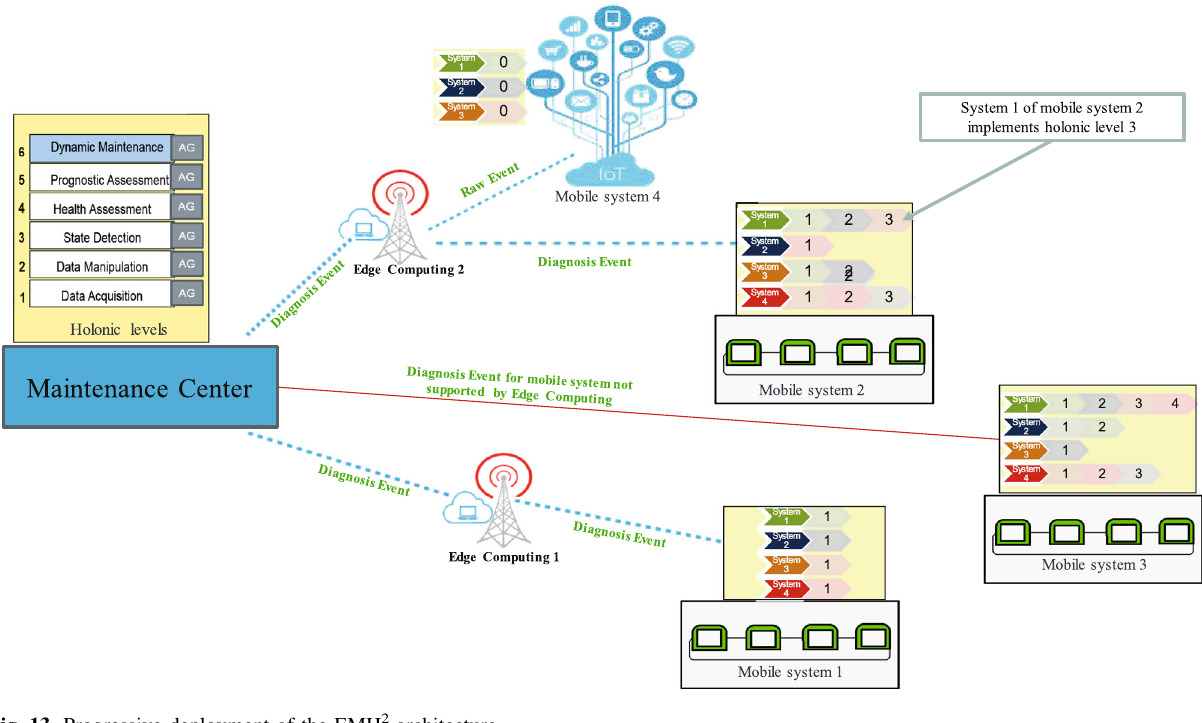
Fig. 13 Progressive deployment of the EMH 2 architecture